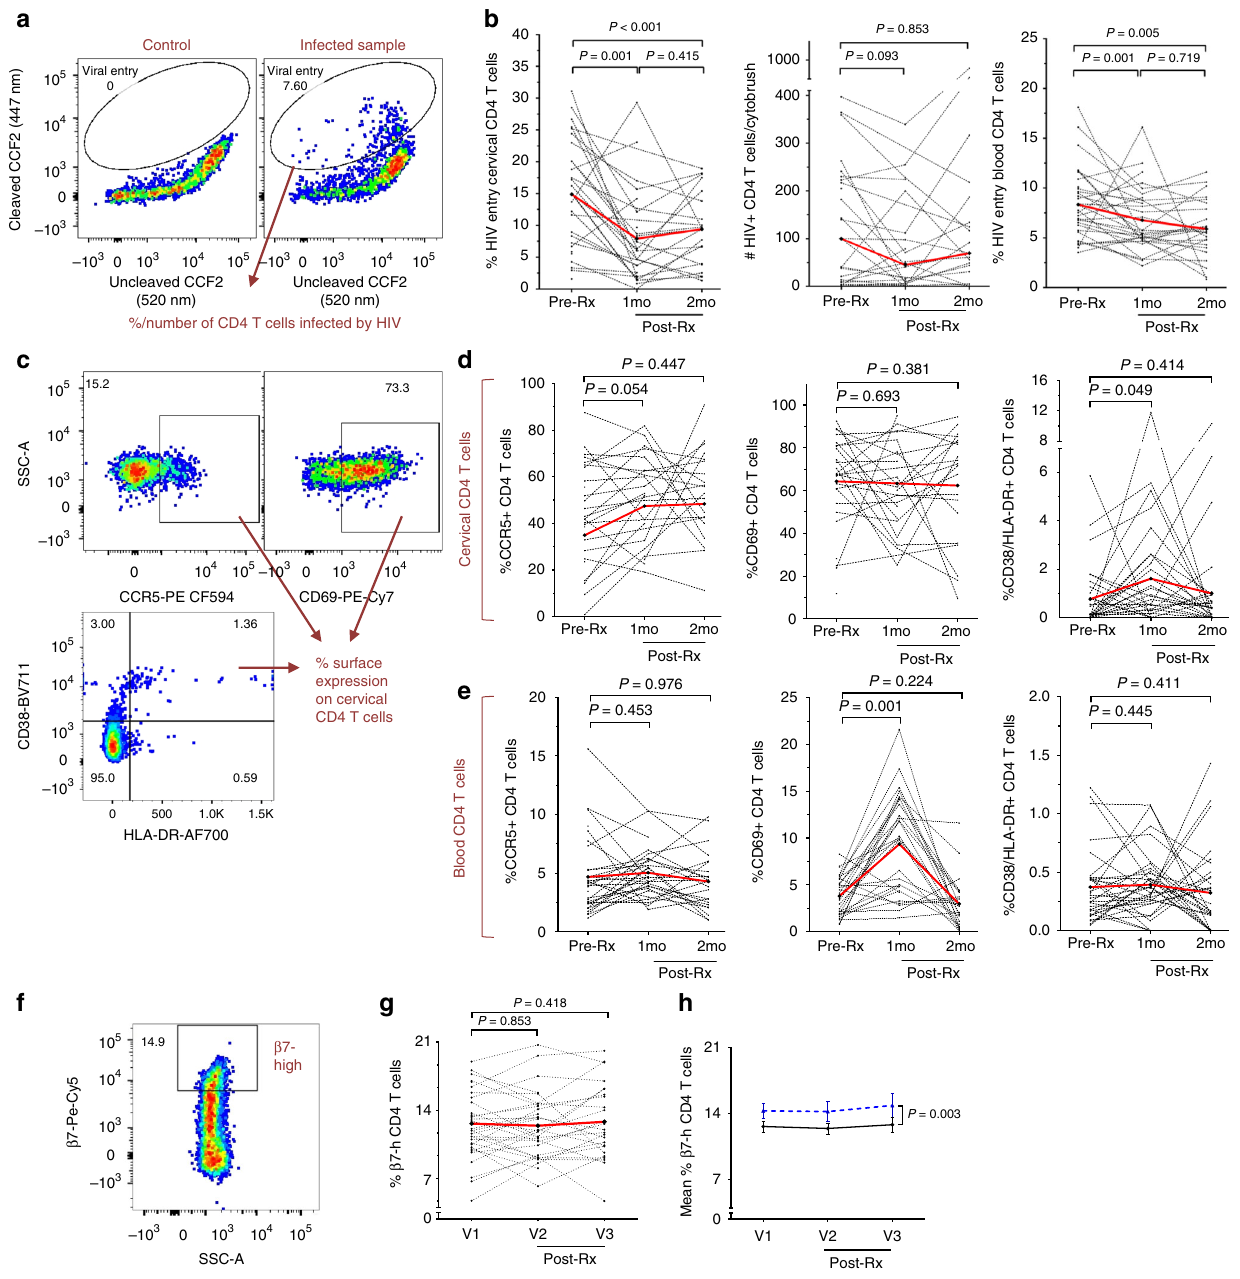
Fig. 2 Cellular HIV entry, immune activation and β 7 high CD4 + T cell levels before and after Sm therapy. a Representative dot plots depicting HIV pseudovirus entry in cervical CD4 + T cells. Cells were pre-gated on single live CD4 + T cells (Supplementary Fig. 3). b Flow cytometric analysis of HIV entry into cervical (percentage and absolute numbers) and blood (percentage) CD4 + T cells. Fold changes and sample sizes for virus entry data are listed in Supplementary Table 8. c Representative dot plots depicting gating for CCR5 + , CD69 + and CD38 + /HLA-DR + cervical CD4 + T cells. Cells were pre- gated on single live CD4 + T cells (Supplementary Fig. 3). d , e Changes in the percentage of cervical ( d ) and blood ( e ) CD4 + T cells positive for CCR5, CD69 and CD38/HLA-DR. Red lines denote mean percentage of cells positive for a marker at each study visit. Representative plots for e are shown in Supplementary Fig. 4. f – h Representative dot plot depicting the gating for integrin b7 high blood CD4 + T cells. Cells were pre-gated on single live CD4 + T cells (Supplementary Fig. 4). g Levels of circulating b7 high CD4 + T cells before and after schistosomiasis treatment depicted as individual participant data, where red line denotes mean β 7 high percentage of cells at each study visit. h Mean percentage of β 7 high CD4 + T cells in the CCA + (black line) vs. Kato-Katz + (blue dashed line) participants. Signi fi cance was assessed by paired t-test ( b , d , e , g ) or (in h ) repeated measures ANOVA (test of between- subjects effects with “ Kato-Katz positivity ” as factor, F = 10.86). In panels b , d , e and g : each dot represents an individual participant, dashed lines connect samples paired across the study visits, n = 23 and 20 for paired cervical comparisons, while n = 31 and 25 for paired blood comparisons at one and two months, respectively. Source data are provided as a Source Data fi le. Sm: Schistosoma